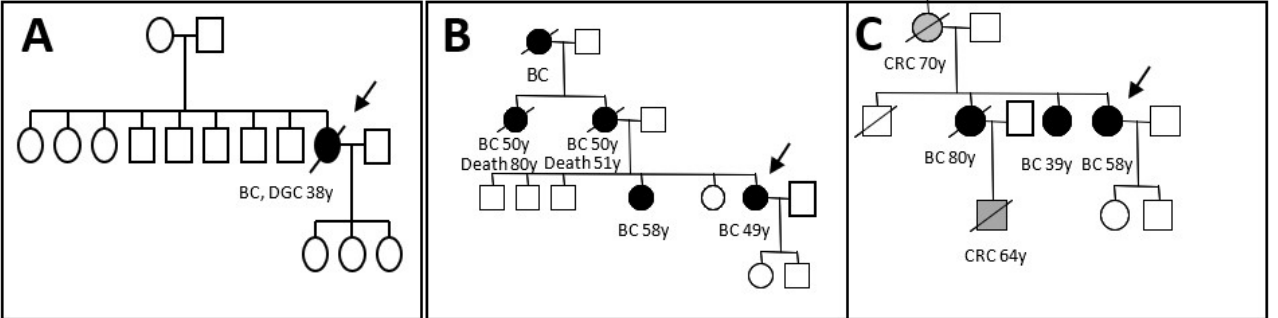
Figure 1. Family history of the three index cases harboring the exon 3, the intron 2 deletions and intron 2 duplication of the CDH1 gene. ( A ) Pedigree of the index case’s family carrying the exon 3 deletion, with proband filled in black and indicated by arrow. ( B ) Pedigree of the index case’s family carrying the intron 2 duplication. ( C ) Pedigree of the index case’s family carrying the intron 2 deletion with ages of affected individuals at onset of disease in years (BC: breast cancer, CRC: colorectal cancer; black arrows: sampled individuals carrying identified variants).